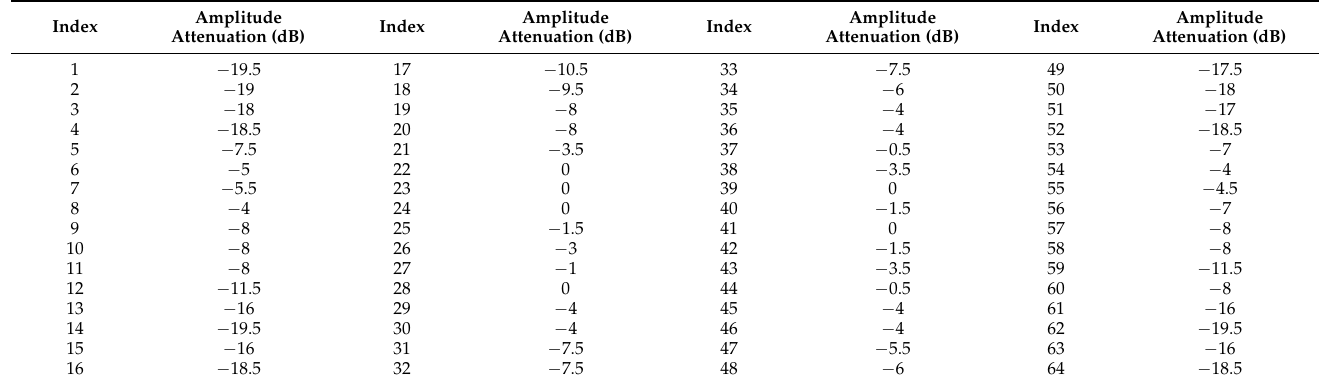
Table 4. The associated amplitude excitation attenuation of 64-element planar phased array antenna.